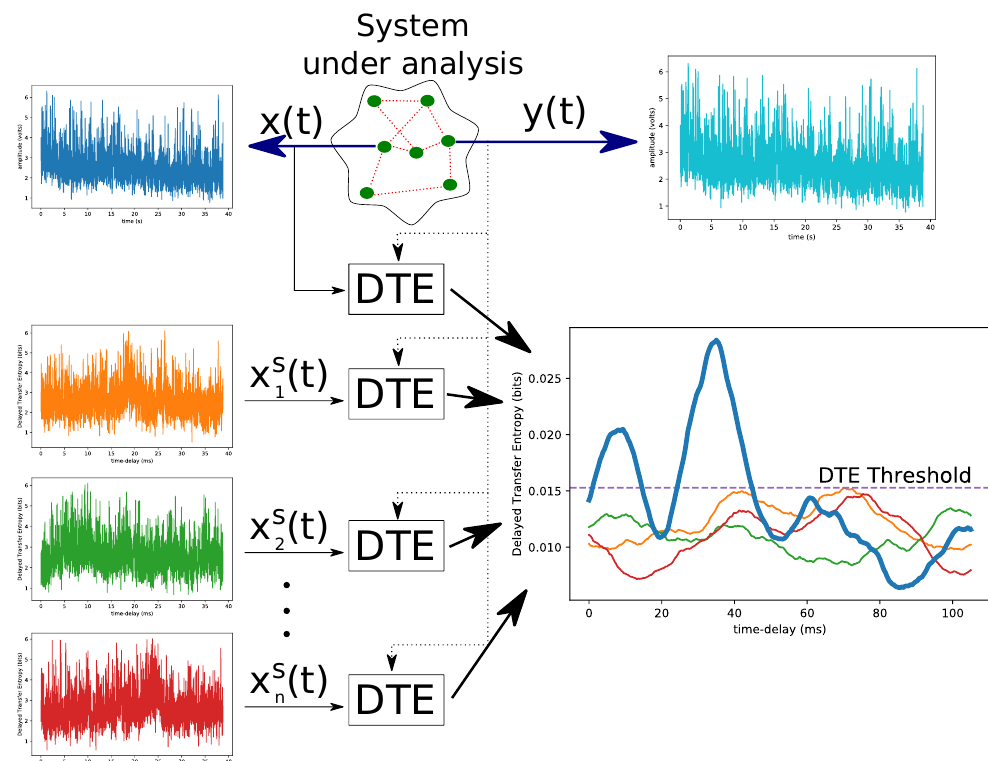
Figure 1. Data analysis and significance levels. From input data, a series of surrogate signals X S n ( t ) is estimated, and for each of the surrogate signals, time delayed transfer entropy is determined. The n repetitions indicate a significance level from Equation (1) against random probabilities with the same power spectra and amplitude distribution as real data. Assuming the number of surrogate n equals three as shown in this figure, DTE Threshold line displayed on the biggest ensemble plot has a significance level of